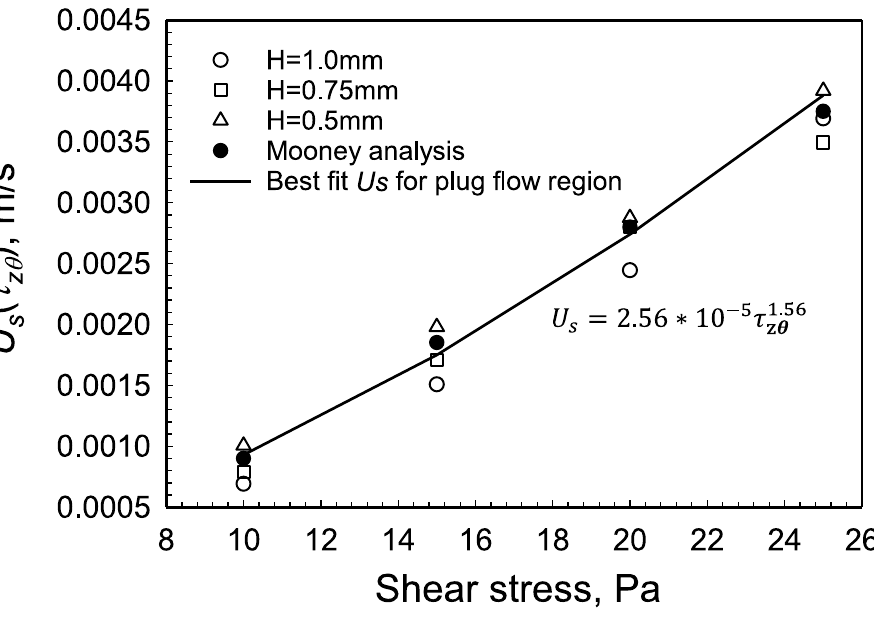
( ) τ R θ , from the data collected z